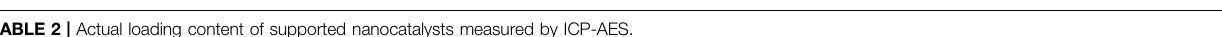
TABLE 2 | Actual loading content of supported nanocatalysts measured by ICP-AES. Sample number Concentration of silver Residence time (s) Content of Ag (wt%) precursor (mM)